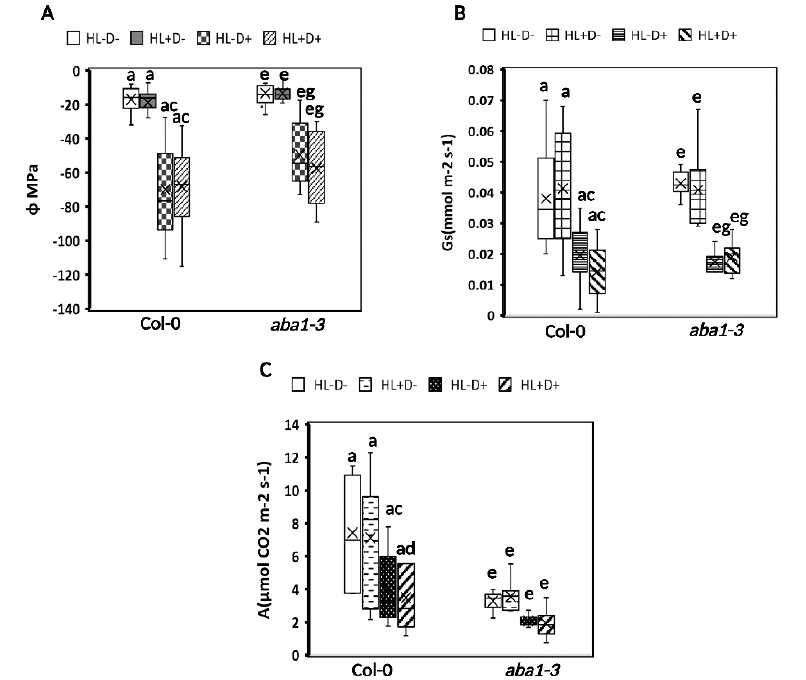
Figure 5. Water, conductance, and assimilation responses were triggered by D, but HL treatment had little to no effect on these responses after subsequent D stress. ( A ) Relative water potential, ( B ) stomatal conductance, and ( C ) carbon assimilation responses were altered by D independent of HL pre-treatments. Measurements were taken at the end of the subjective drought period for all four treatments. The data are a representation of one biological replicate with mean values. The other biological replicates are shown in Supplementary Figure S8. Statistical significance analyzed by one-way ANOVA test and post-hoc Tukey’s HSD test.